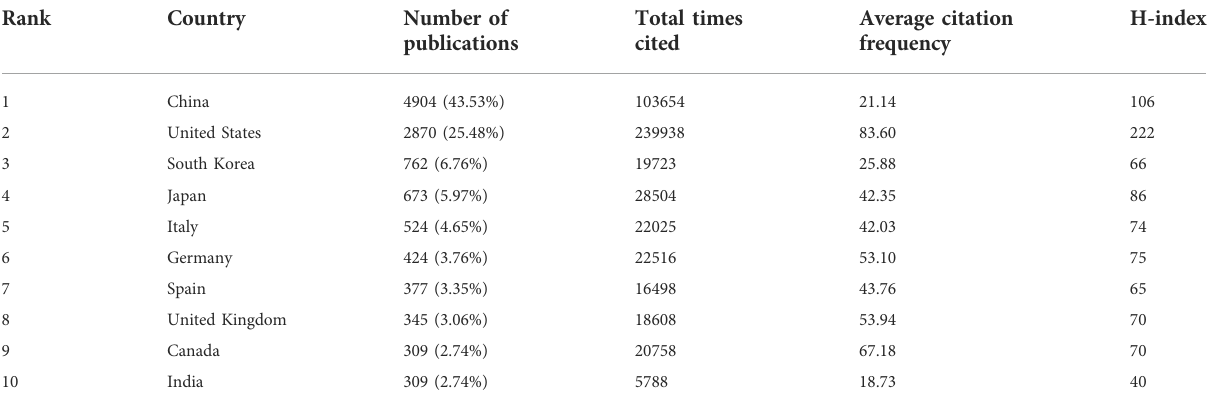
TABLE 3 The top 10 highest productive countries for the study of sirt1.